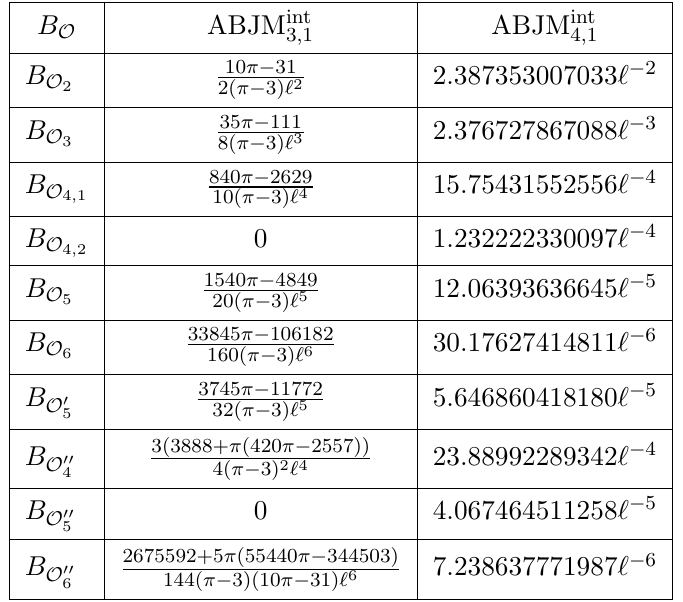
Table 5 . Values of unnormalized two-point coe(cid:14)cients in the 1d theory corresponding to super- conformal primaries in ABJM int with N = 3 ; 4. N; 1